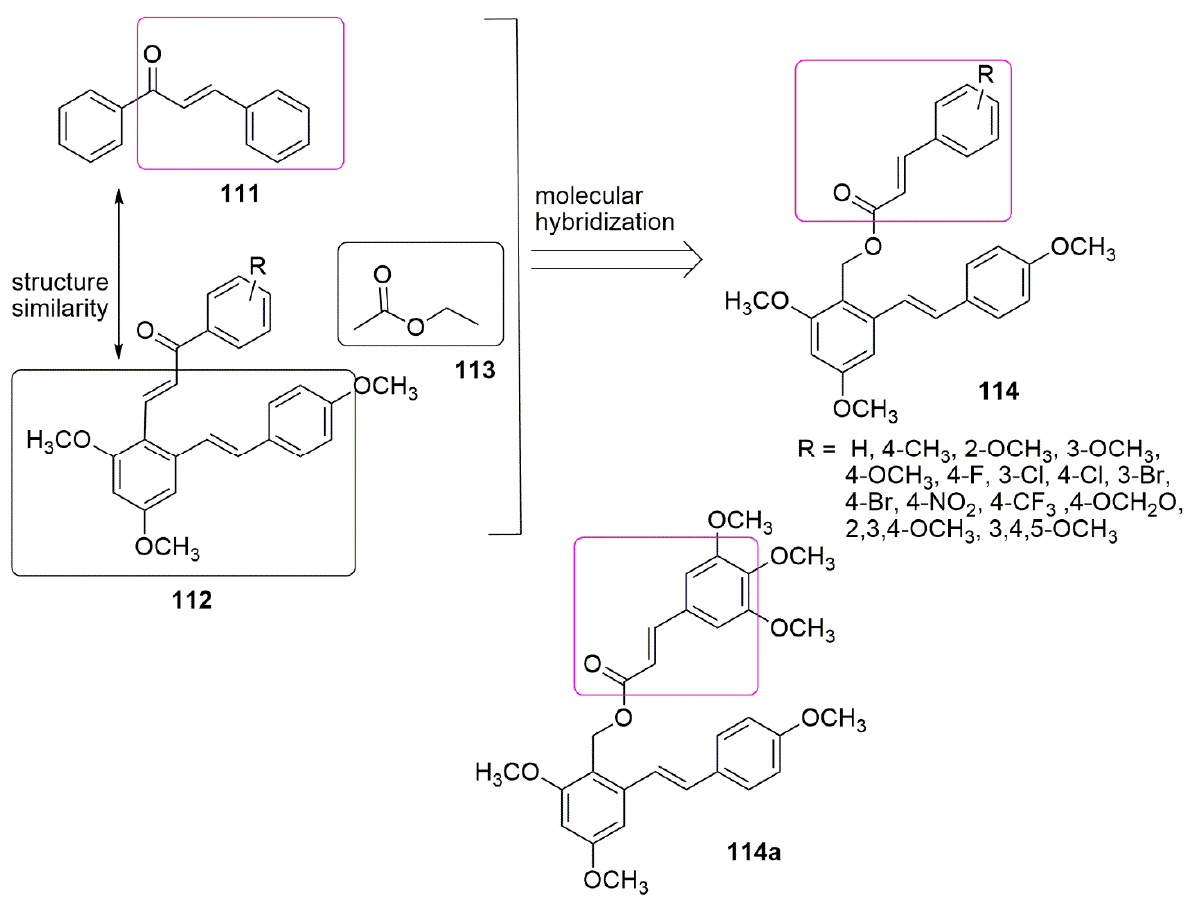
Figure 33. Chalcone derivatives bearing acyl ester functional group.